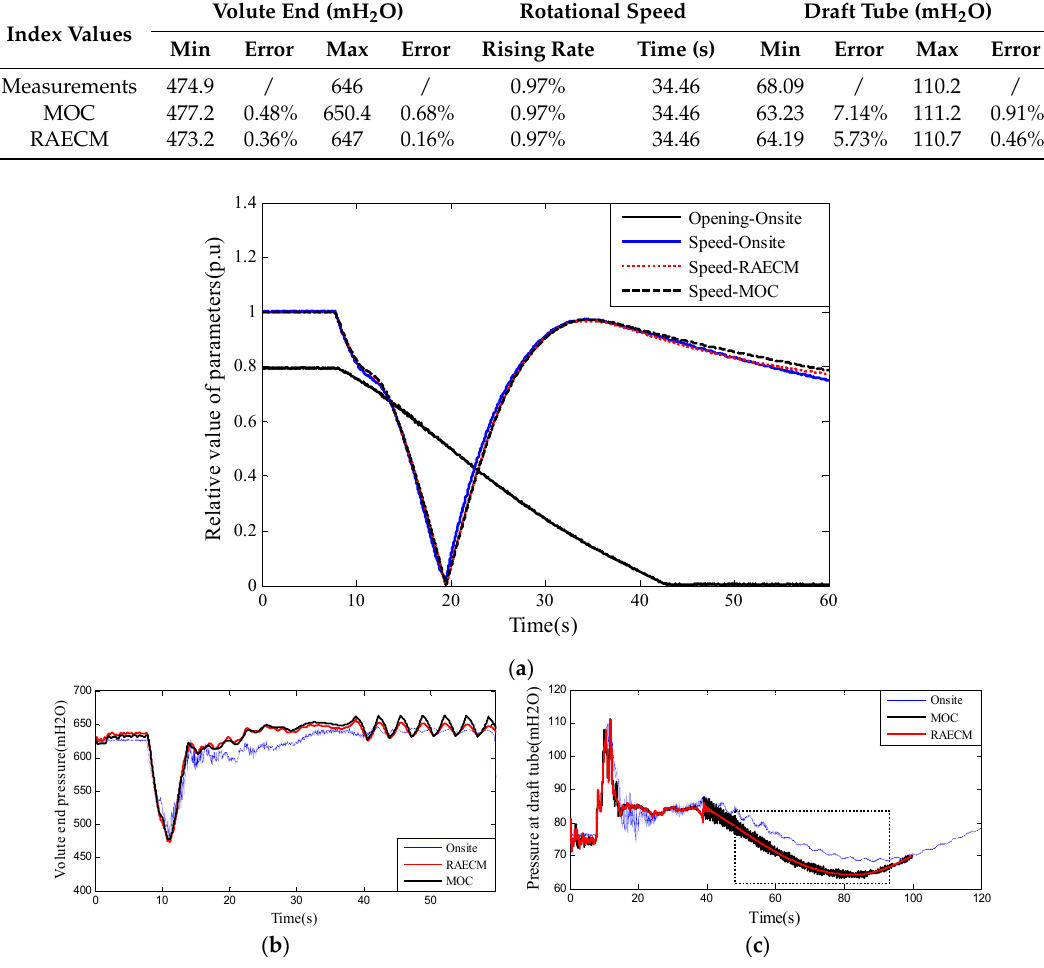
Figure 13. Transient process of pump outage conditions with different models: ( a ) guide vane opening and speed; ( b ) pressure at volute end; ( c ) pressure at draft tube.